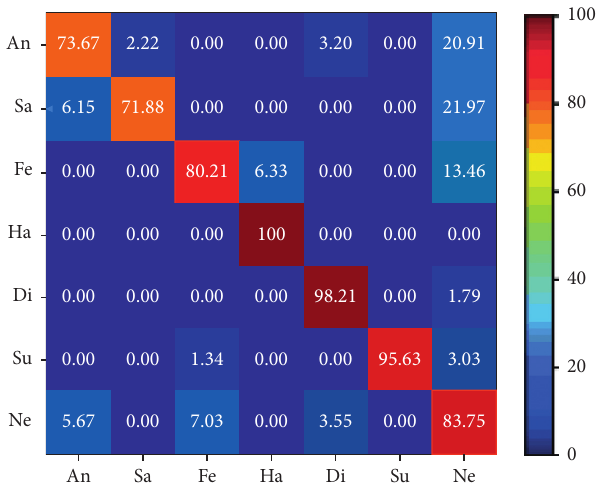
Figure 10: The confusion matrices on JAFFE dataset.